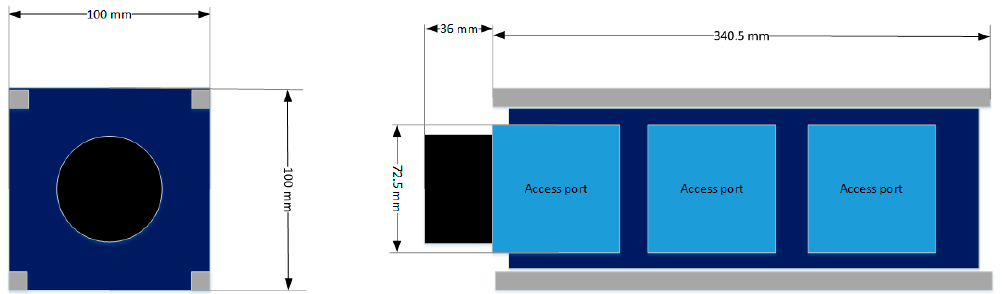
Figure 1. Layout of a 3U+ cubesat platform, according to standard cubesat specification.